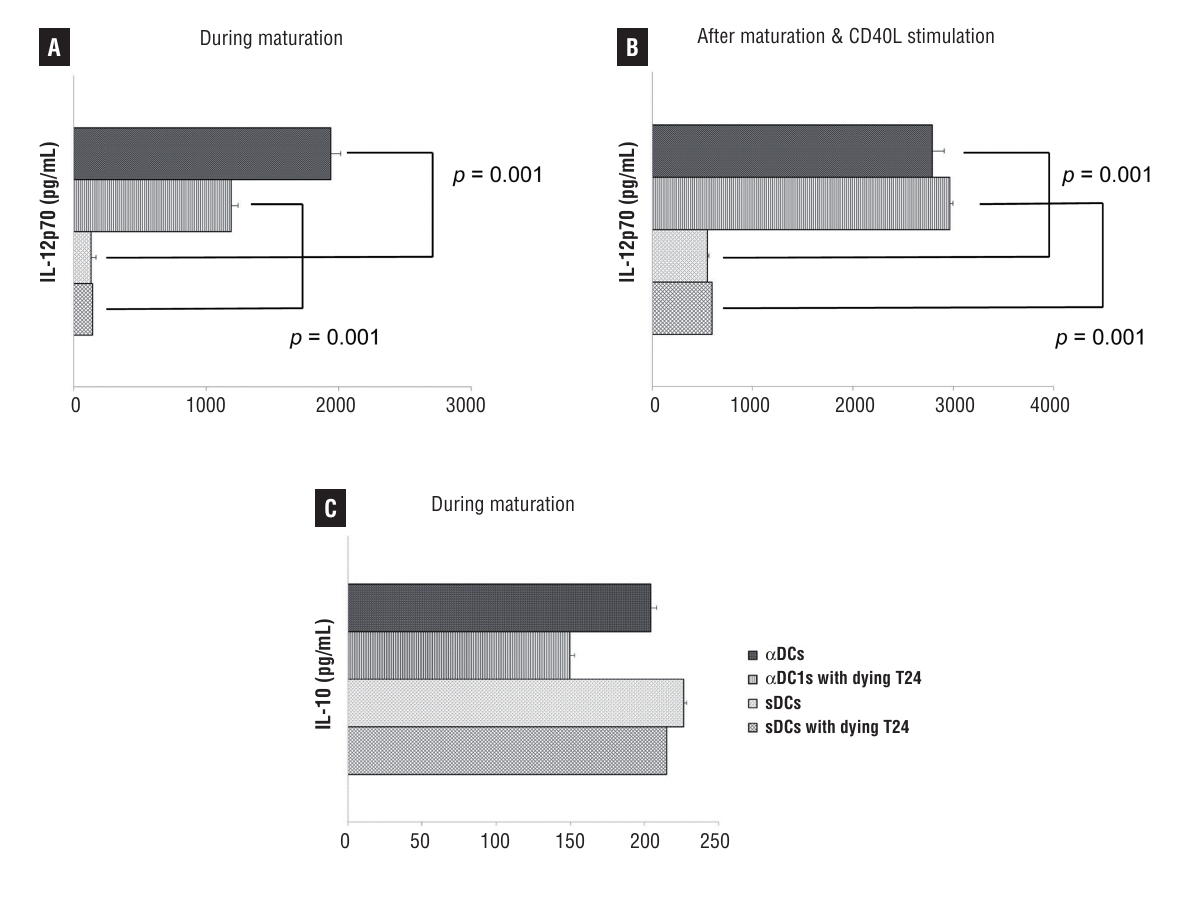
figure3- comparison of cytokine production by Dcs loaded with or without tumor cells in A) primary culture supernatant during generation of Dcs, and B) after stimulation with cD40L-transfected J558 cells. The α Dc1s showed significantly higher production of IL-12p70 during maturation and after stimulation with cD40L-transfected J558 cellsthan the sDcsdid (p<0.05). In addition, production of the inhibitory cytokine IL-10 by α Dc1s was not significant.c)Results, expressed as mean (pg/mL) ±sD of triplicate cultures, are representative of five independent